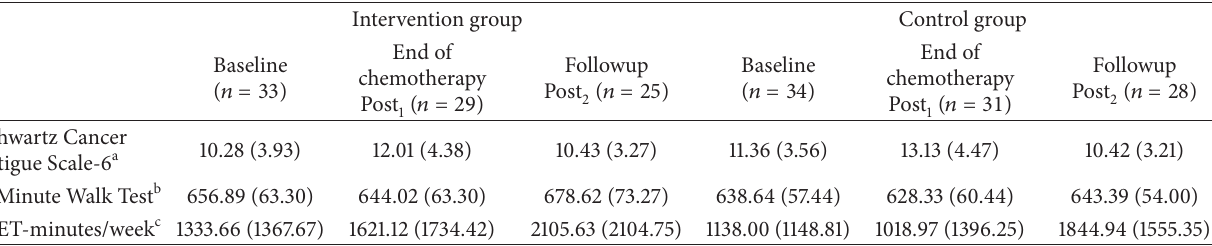
Table 2: Mean scores and standard deviations for study variables at baseline, end of chemotherapys and 6-month follow-up tests for the intervention and control groups.